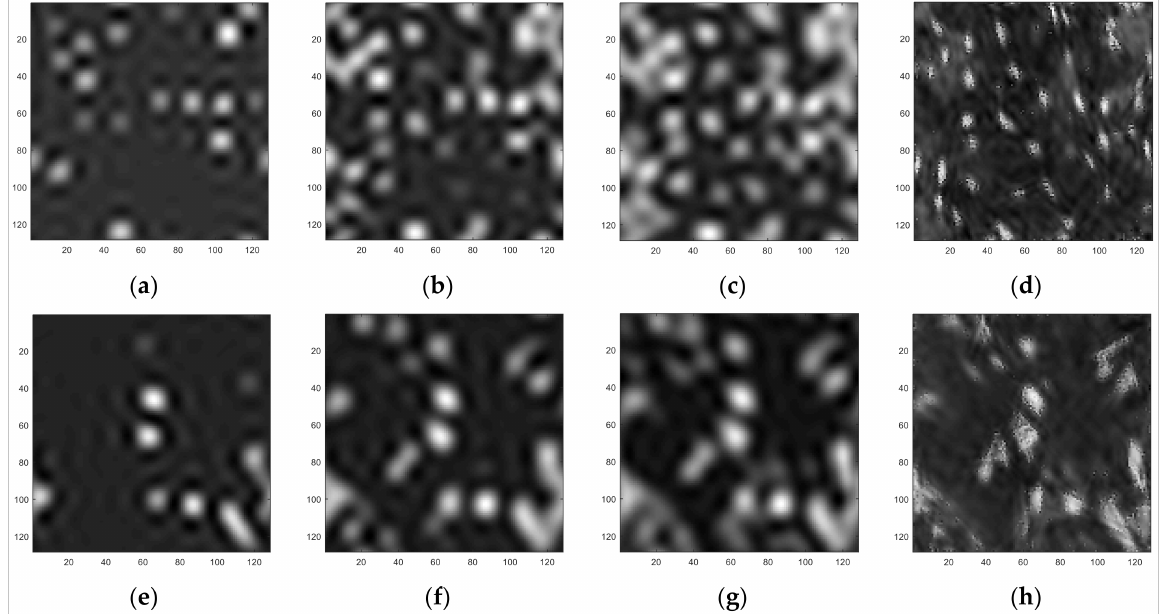
Figure 8. Curvelet Decomposition by Scales 1–4 ( a – d ) for MRE, Scale 1–4 ( e – h ) for MRE with MWCNTs. Areas in strip-shape light color are denoted as iron particles, dark colors are silicon rubber matrix, and cotton-like material with small clusters is the additives of MWCNTs. Specifically, scale four of MR nanocomposite reveals MWCNTs closely wrap the scattered iron particles, showing a distinct bonding between matrix and particles. It can be seen from Figure 9 that the normalized energy distribution of curvelet coeffi- cients at each scale is further studied by calculating the sum of squares of the amplitude of | c ( a , b , θ ) | 2 . curvelet coefficients, denoted as: E ( a ) = ∑ b , θ